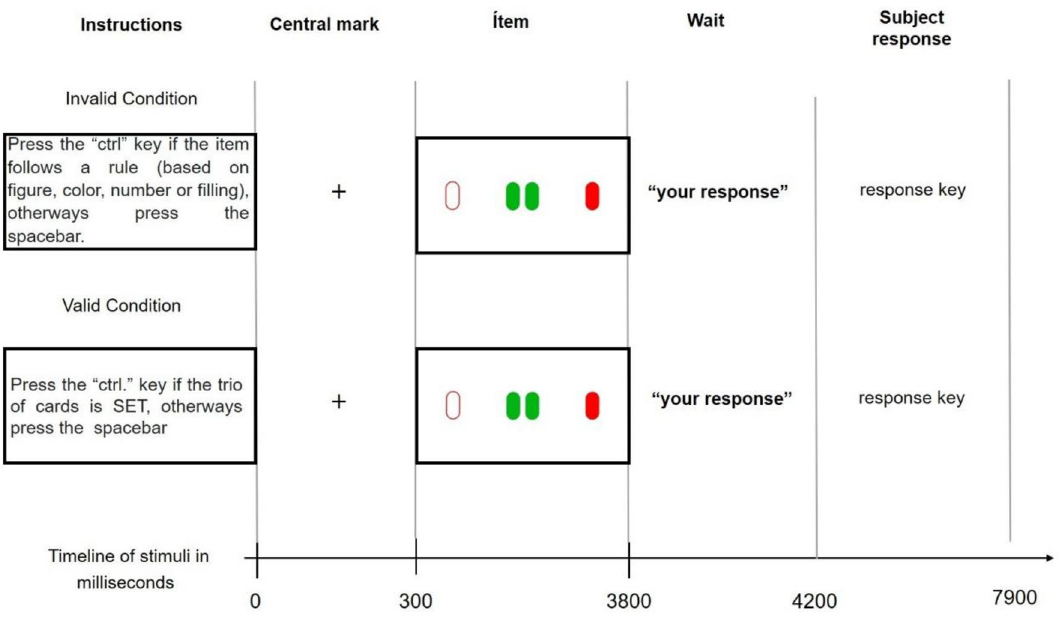
Figure 2. Timeline of stimuli in